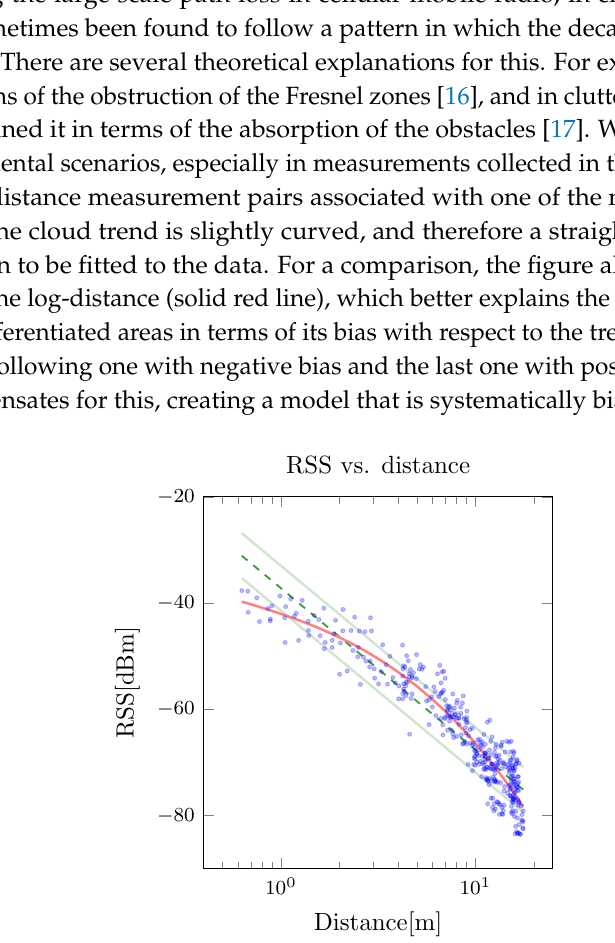
Figure 3. Received signal strength (RSS)-distance scatter plot for a set of measurements obtained in the office. The dashed greed line corresponds to a log-normal model fitted to the data, and the solid red line to a third order polynomial on the